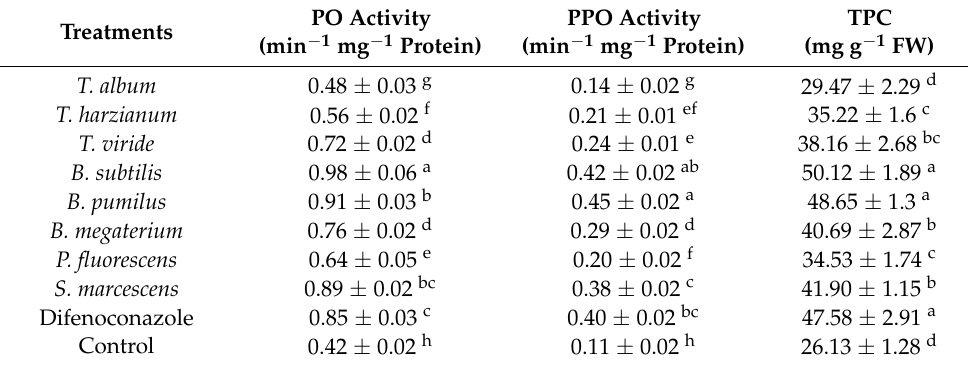
Table 4. Peroxidase and polyphenol oxidase activities and total phenol content in powdery mildew- infected celery leaves in response to biocontrol agents and synthetic fungicide during the growing seasons 2018/2019 and 2019/2020 under field conditions. PO Treatments